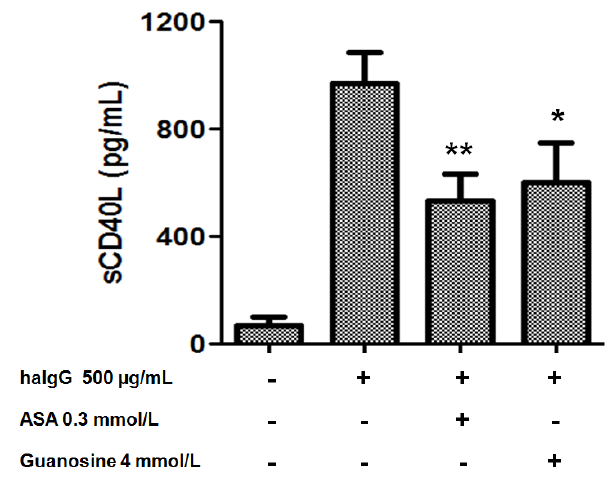
Figure 7. Effect of guanosine on release of sCD40L from platelets induced by haIgG. Washed platelets were pretreated with saline, ASA, acetylsalicylic acid 0.3 mmol/L or guanosine (4 mmol/L) for 15 min at 37 °C and then stimulated by haIgG (500 µg/mL). The graph depicts the mean ± SEM of n = 3 experiments. * p < 0.05, ** p <